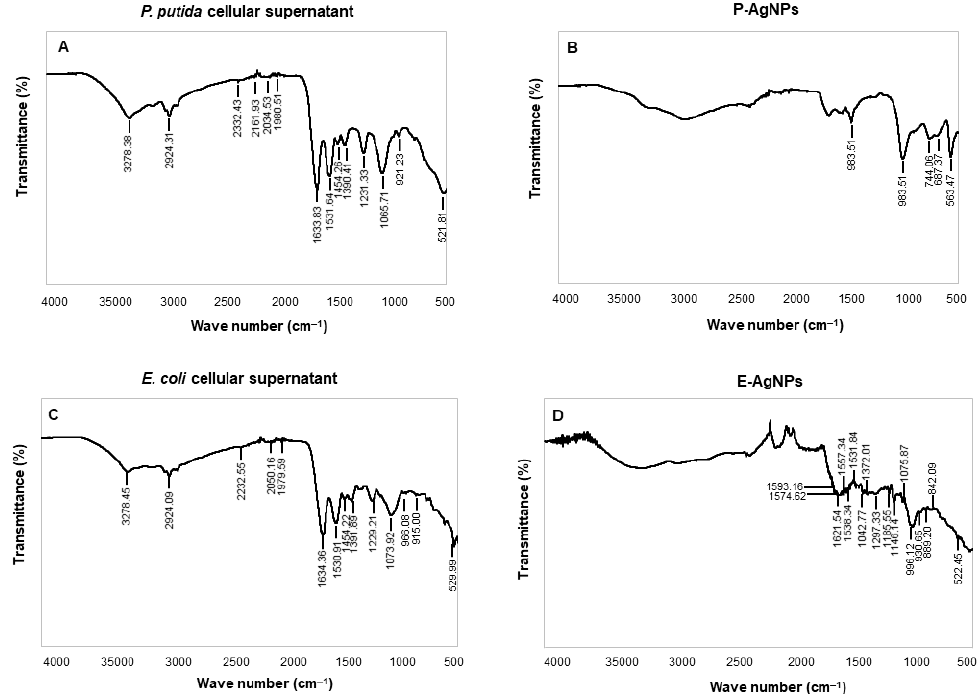
Figure 9. FTIR spectrum of ( A ) freeze-dried cellular supernatant of P. putida and ( C ) E. coli , and ( B ) pure P-AgNPs, and ( D ) E-AgNPs, which demonstrate the active surface groups for respective sam- ples.